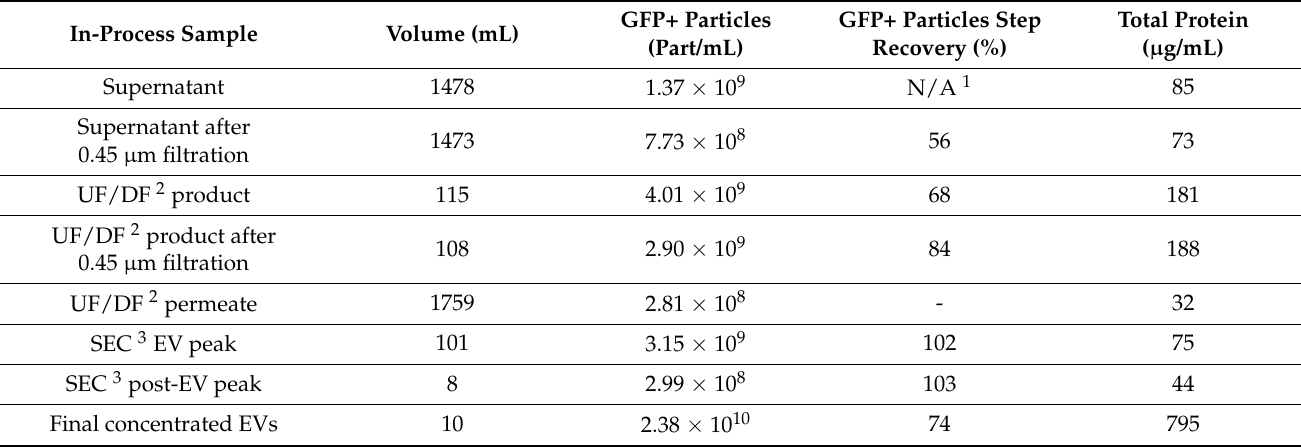
Table 2. In-process quantification of GFP+ particles by flow virometry and total protein by RC/DC during one repeat of Clone 92 EVs isolation process.